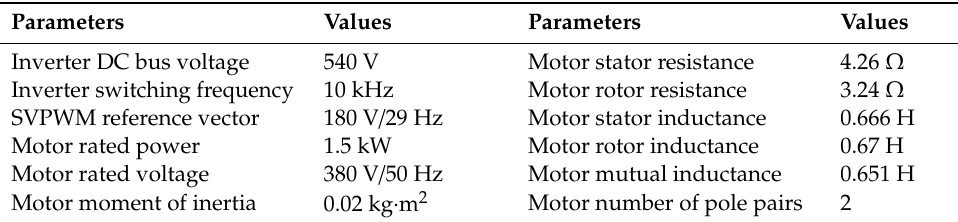
Table 3. Simulation and experiment parameters.